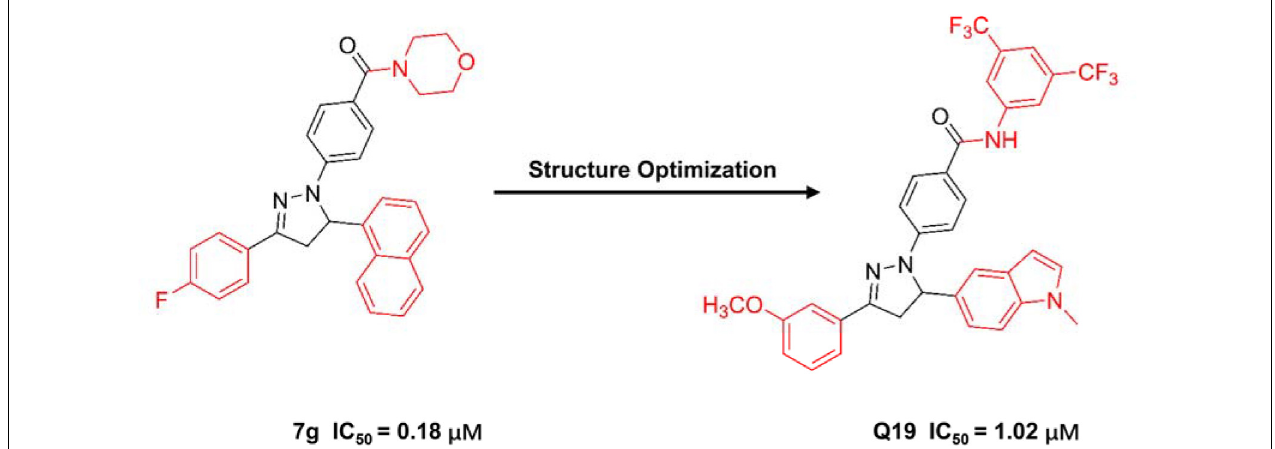
FIGURE 6 | The structure of compound 7g and